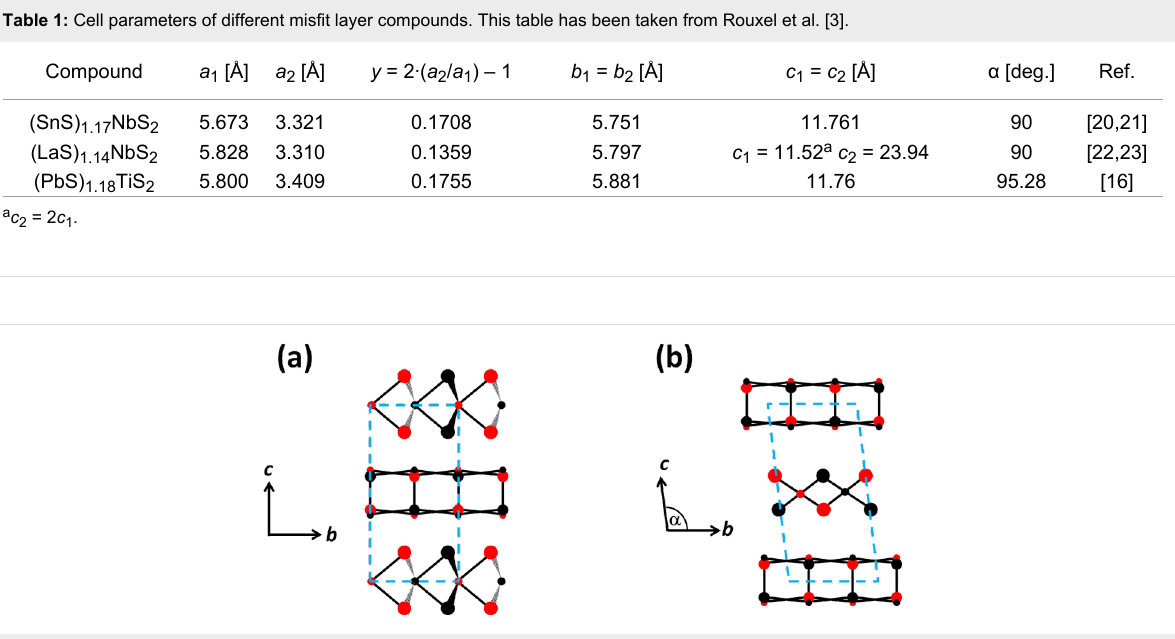
Figure 3: Side view of two unit cells of misfit layer compounds with the TMX 2 component either in trigonal prismatic (a) or octahedral coordination (b). The unit cells are denoted by the blue boxes. Adapted with permission from [3]. Copyright 1995